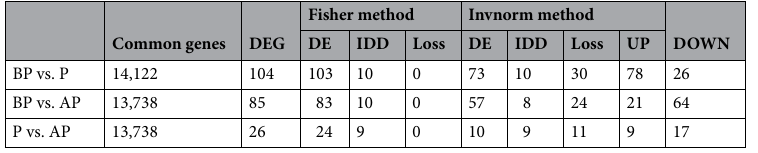
Table 1. Results of meta-analysis of RNA-Seq data using Fisher and Invorm methods. DE: corresponds to the number of differentially expressed genes. IDD: Integration Driven discoveries (the number of genes that are declared DE in the meta-analysis that were not identified in any of the individual studies). Loss: the number of genes that are identified DE in individual studies but not in